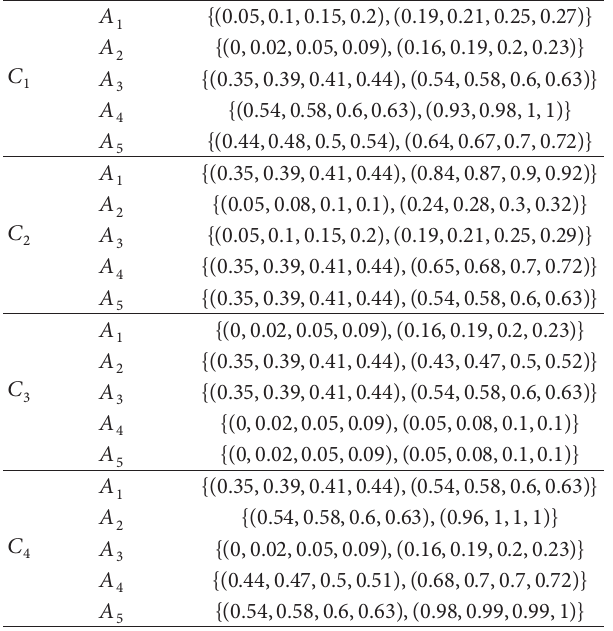
Table 3: Decision matrix ( 8 ( 𝑒 7 , and 𝑒 8